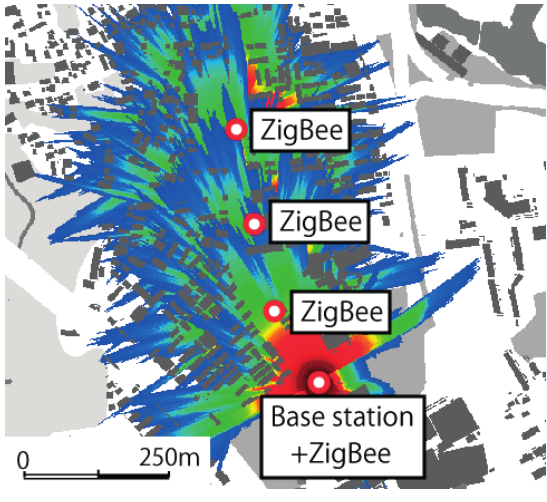
Figure 9. Figure of placement